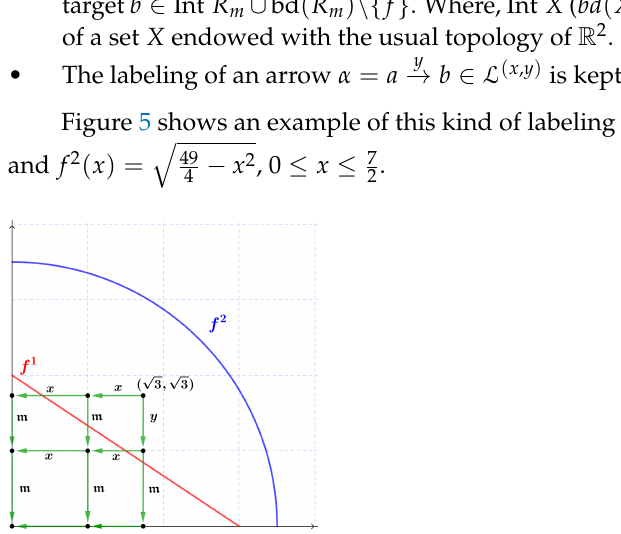
Figure 5. Example of a labeling with mutations associated with a region R ( (cid:113) 49 7 )) 3 ) , x 2 ( 0 x 2 4 − ≤ ≤